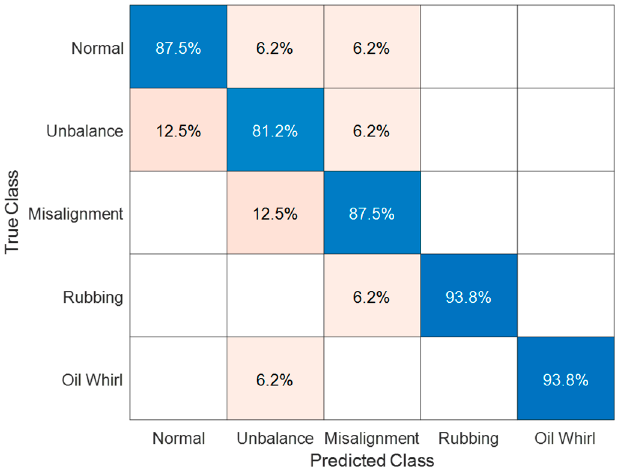
Figure 13. Training/validation confusion matrix of cubic SVM on the features automatically extracted by the pretrained deep learning model from the original RK4 data.